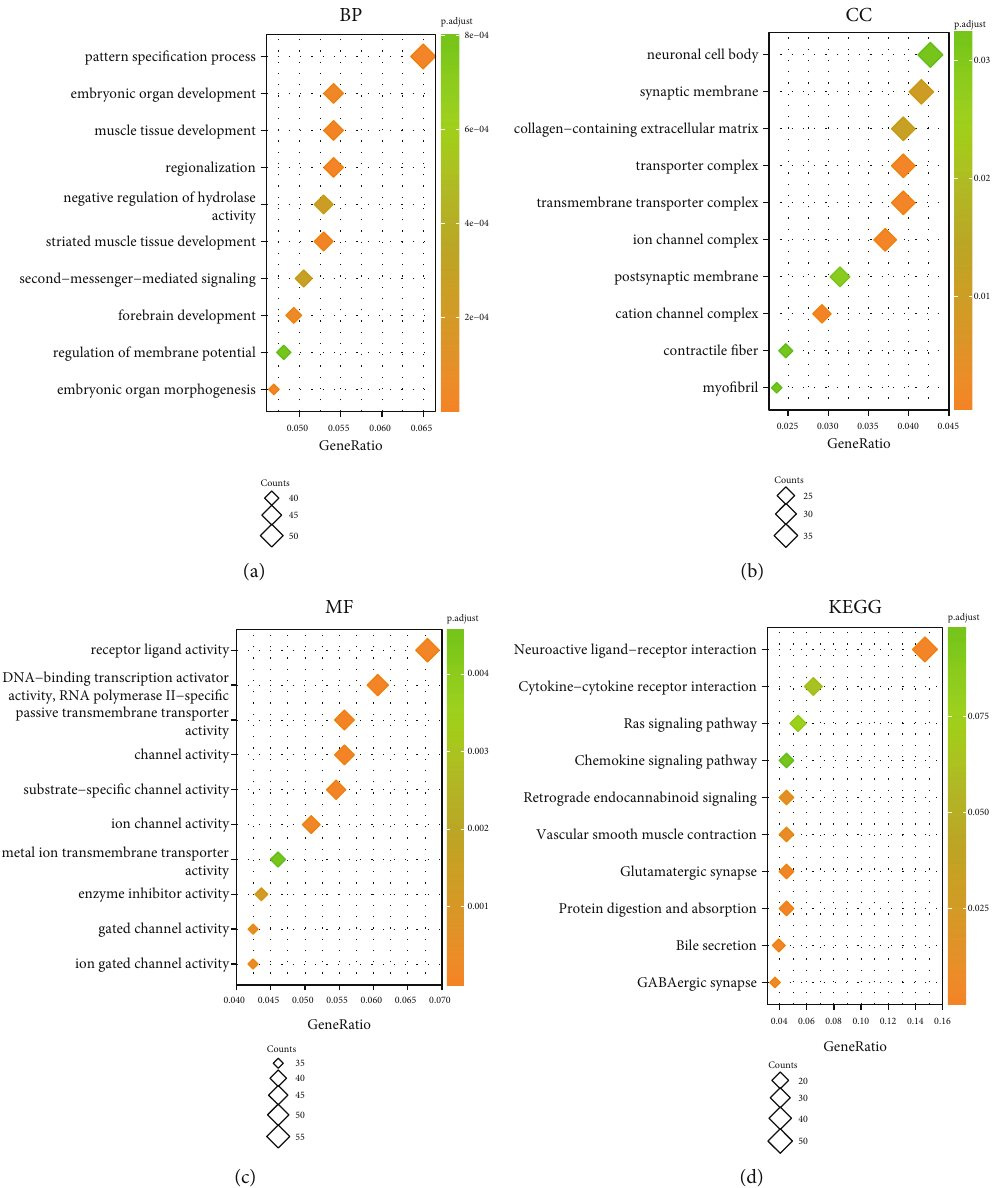
Figure 6: Functional enrichment analysis of PRNP in ovarian cancer. (a – c) GO (BP, CC, and MF) enrichment analysis of PRNP in ovarian cancer (Xiantao). (d) KEGG enrichment analysis of PRNP in ovarian cancer. BP: biological process; CC: cellular components; MF: molecular